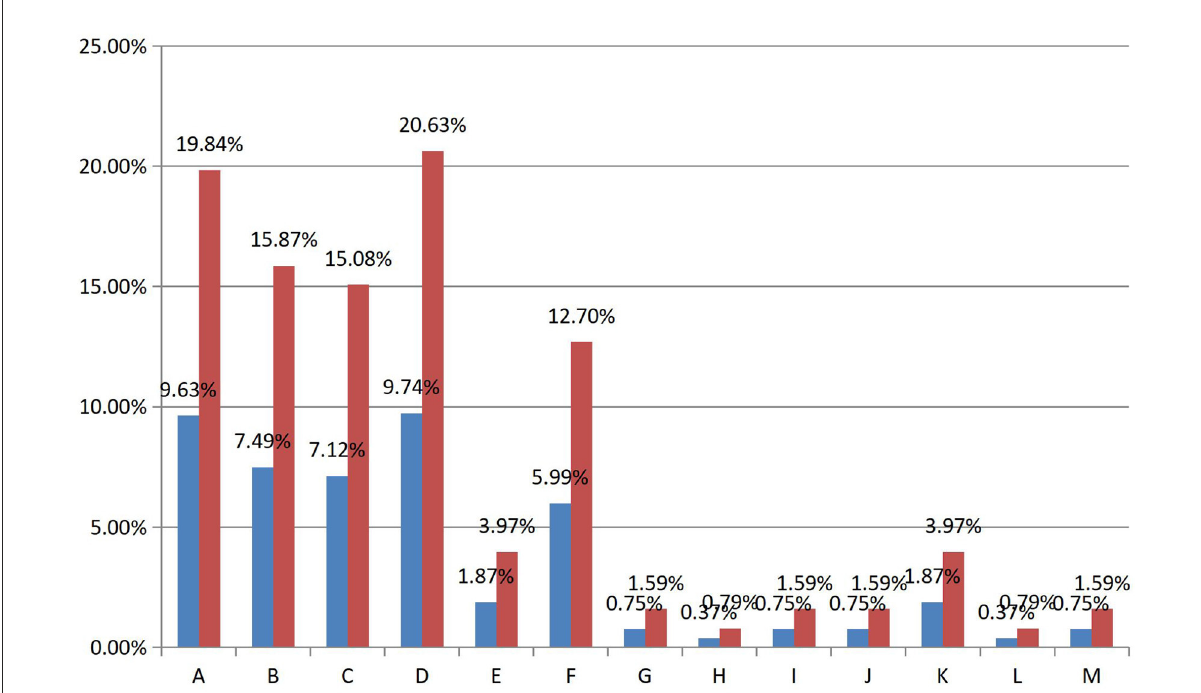
FIGURE3 Summary table of response rates and prevalence rates. (A) I want to help the streamer complete the tasks prescribed by Douyu. (B) I want to encourage the streamer to present their live content better. (C) I am impressed by the streamer’s skills. (D) I love the streamer’s personality. (E) I love the streamer’s looks. (F) I love the streamer’s style. (G) I feel like the streamer and I are friends. (H) I want the streamer to notice me. (I) I want the streamer to talk to me in the live stream. (J) I see streamers thanking viewers for their gifts; I also want to be publicly thanked. (K) I